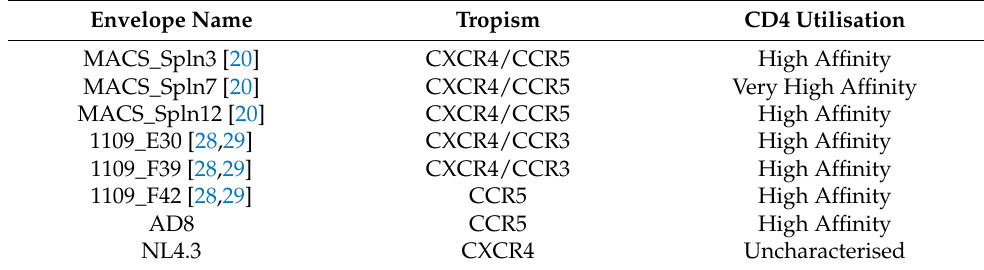
Table 1. List of Shortlisted HIV-1